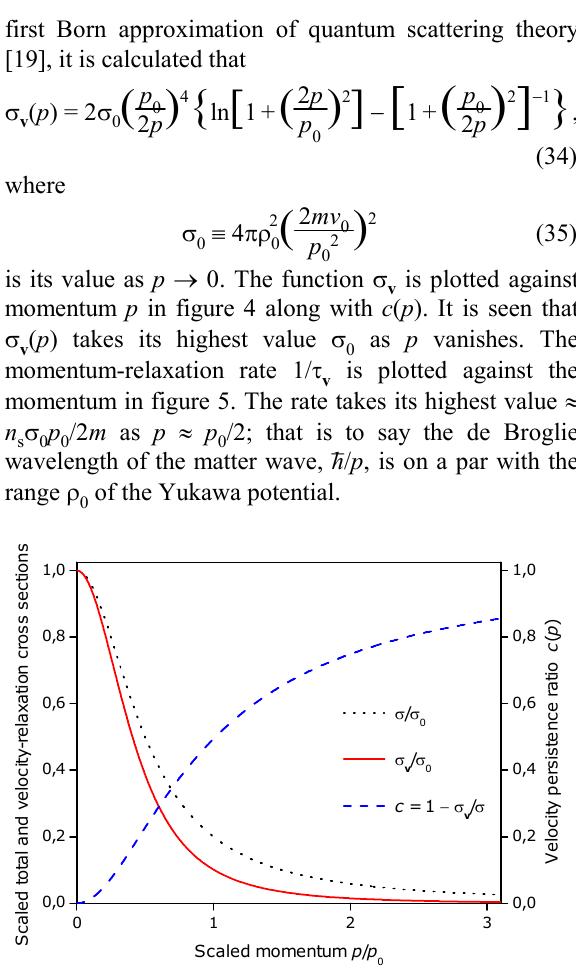
Fig. 4 . The total scattering cross section ( σ ) and velocity- ) of the Yukawa potential relaxation scattering cross section ( σ v v ( ρ ) are plotted as functions of the momentum p . The _ is h / ρ , where ρ is the range of v ( ρ ). The momentum scale p 0 0 0 cross sections have been scaled by the value σ at a vanishing 0 energy. Also shown is the ratio of velocity persistence c ( p ), or average direction-cosine of the scattering angle ( p , p' ), as a function of p = p' .